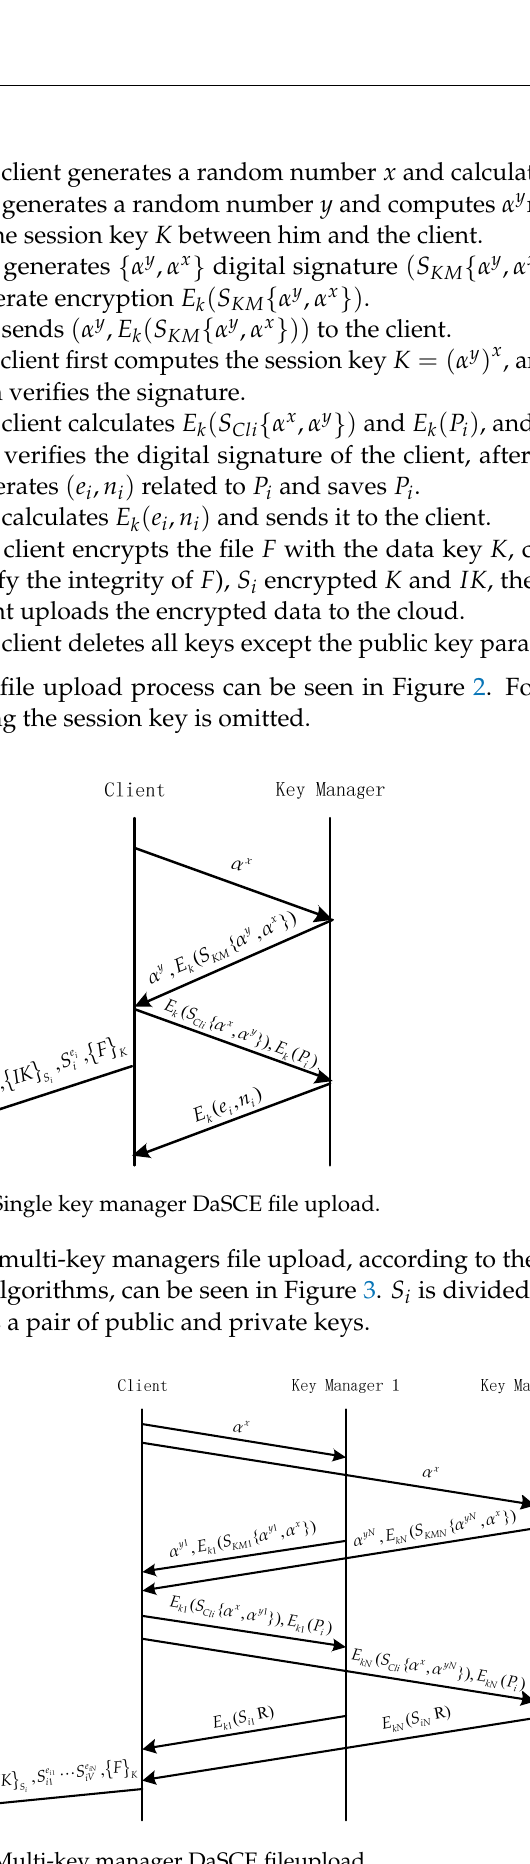
Figure 3. Multi-key manager DaSCE fileupload.